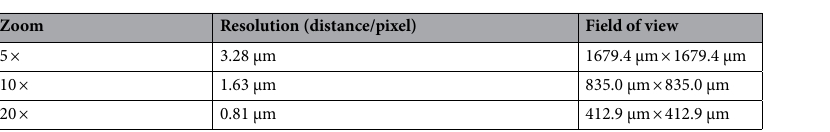
Table 1. The relation between the image resolution and FOV with the zoom ranges of 5 ×, 10 ×, and 20 ×.